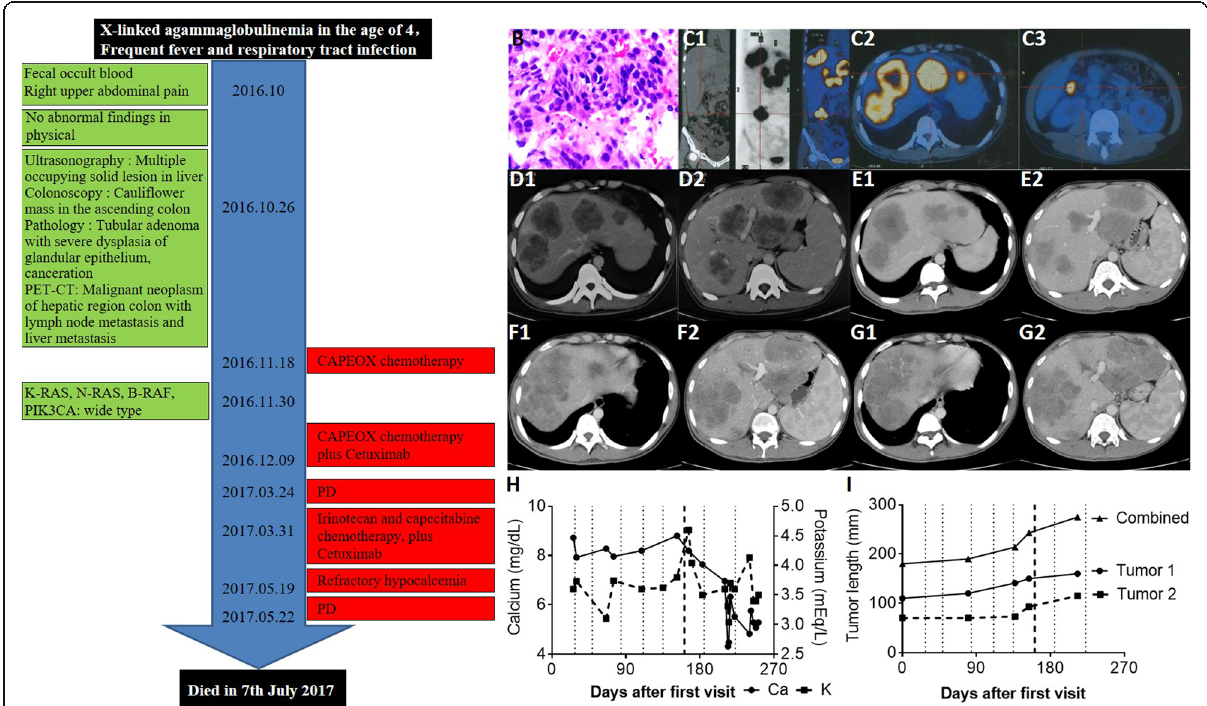
Fig. 1 The timeline, diagnosis and progression focus. a The timeline of hospitalization: This patient was diagnosed with XLA at the age of 4. He suffered upper abdominal pain on Oct 2016, and was diagnosed with advanced colorectal cancer with liver metastasis by liver biopsy (( b ), magnification, ×100) and PET-CT scan ( c ). Abdominal CT scans on Oct 21th 2016 ( d ) and Jan 9th 2017 ( e ) showed that the tumor was stabilized after the first two treatment cycles. However, abdominal CT scans on Mar 24th 2017 ( f ) and May 22th 2017 ( g ) showed metastatic tumor progressed. Blood calcium/potassium levels ( h ) and tumor load ( i ) were recorded throughout all treatment cycles. The dotted lines indicate the starting time of each chemotherapy treatment cycle. The dark dotted line indicates the sixth treatment cycle when oxaliplatin was replaced by